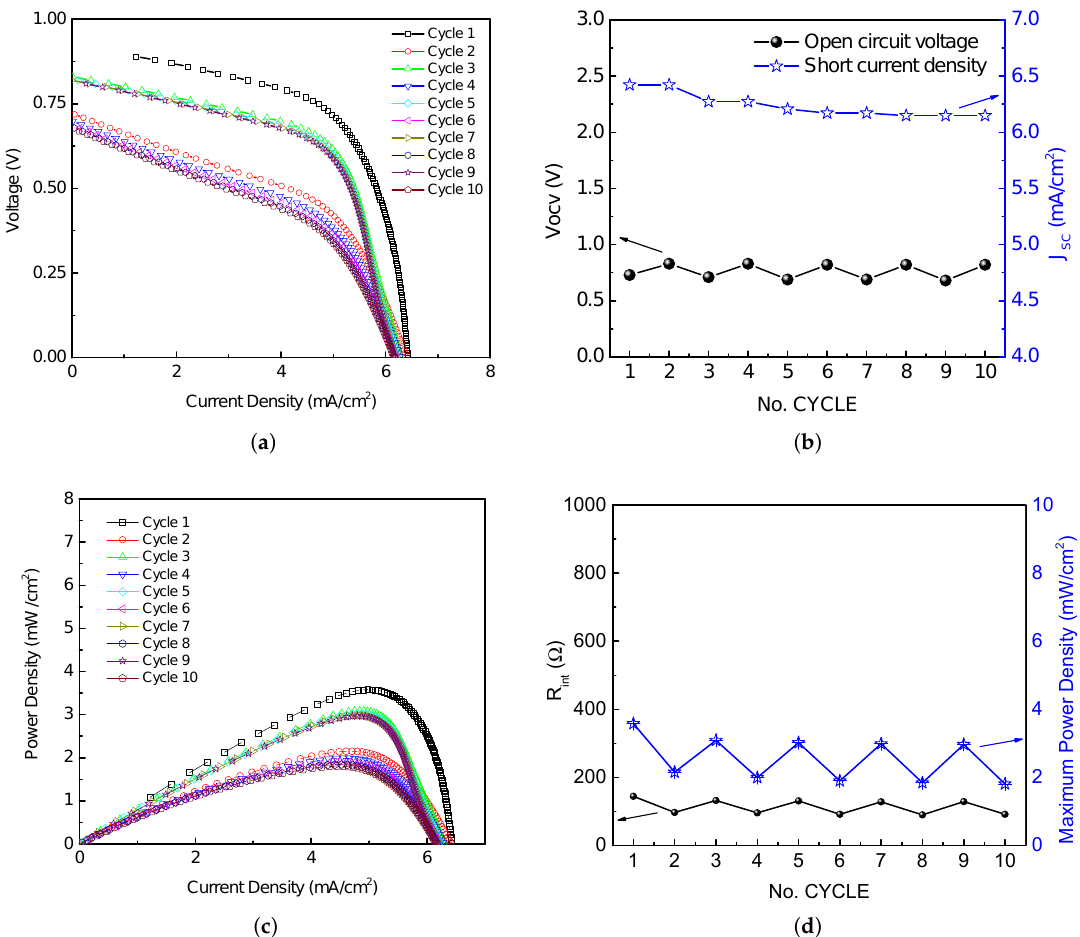
Figure 10. ( a ) Polarization curve of PMFC when the controlled potential is maintained for ten cycles; ( b ) Comparative analysis of the open-circuit voltage (black line) and short-circuit current (blue line) for ten cycles; ( c ) Power curve of PMFC; and ( d ) maximum power density (black curve) per cycle and internal resistance parameter (blue curve) per